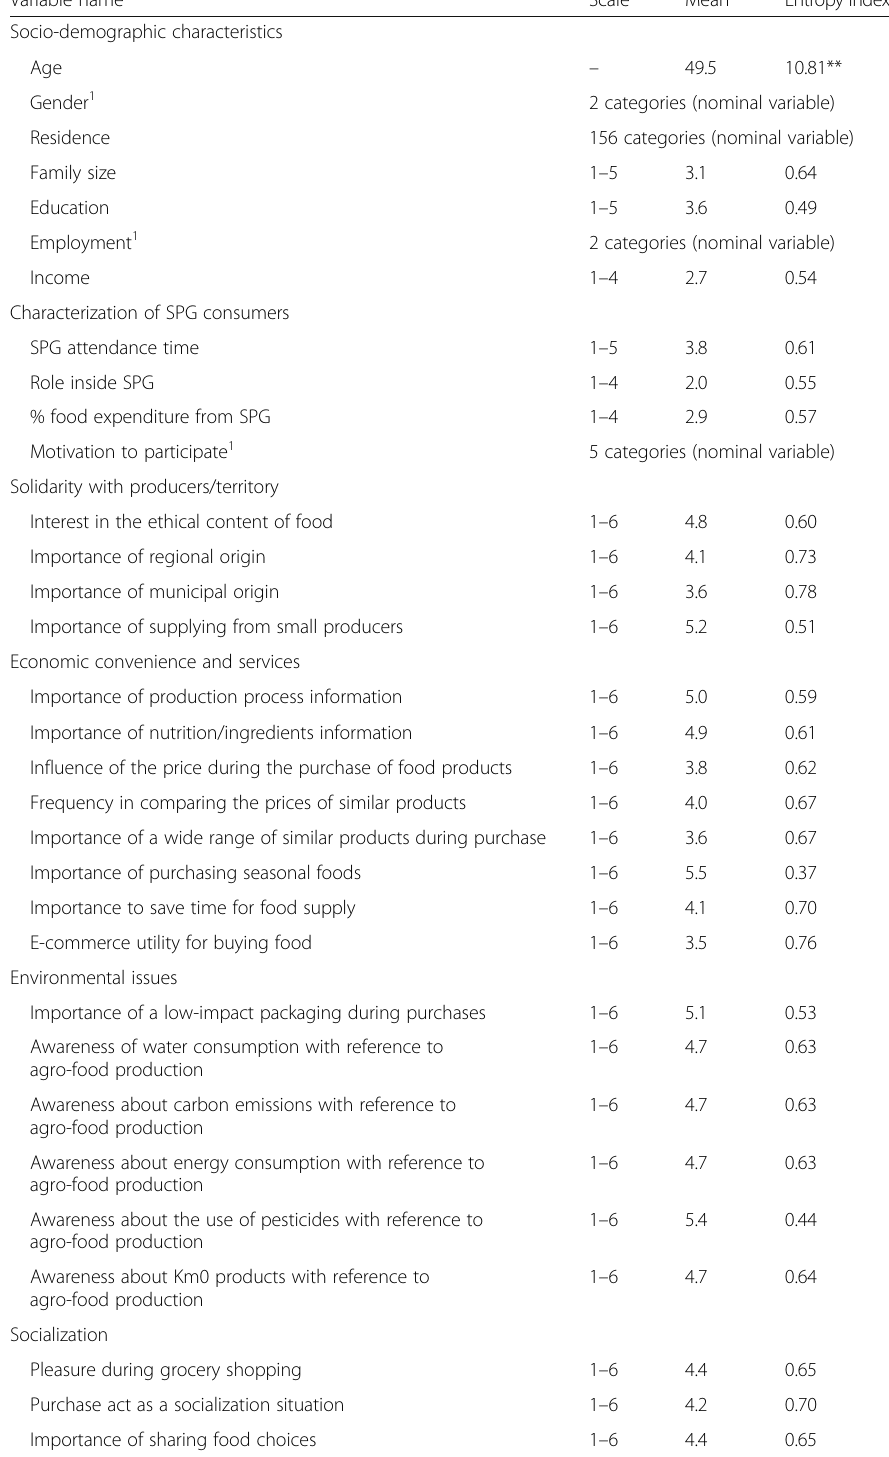
Table 1 Variable description and main descriptive